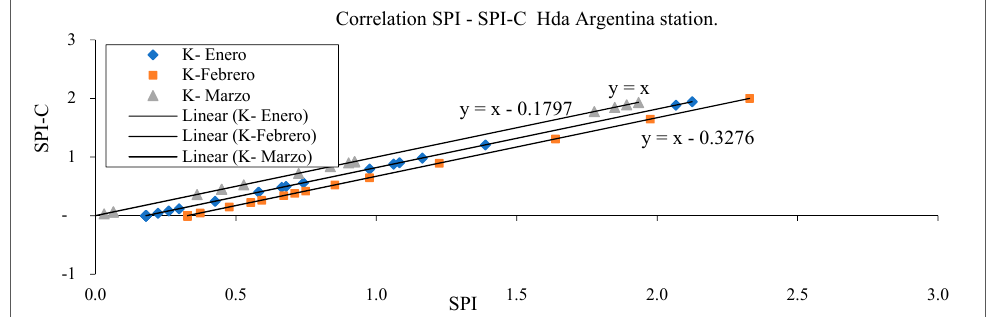
Figure 19. SPI-SPI-C, Tolú station correlation. Table 3. Calculation of the fit of the model and correlation of the SPI. Adjustment Coefficient K (SPI-C) Study